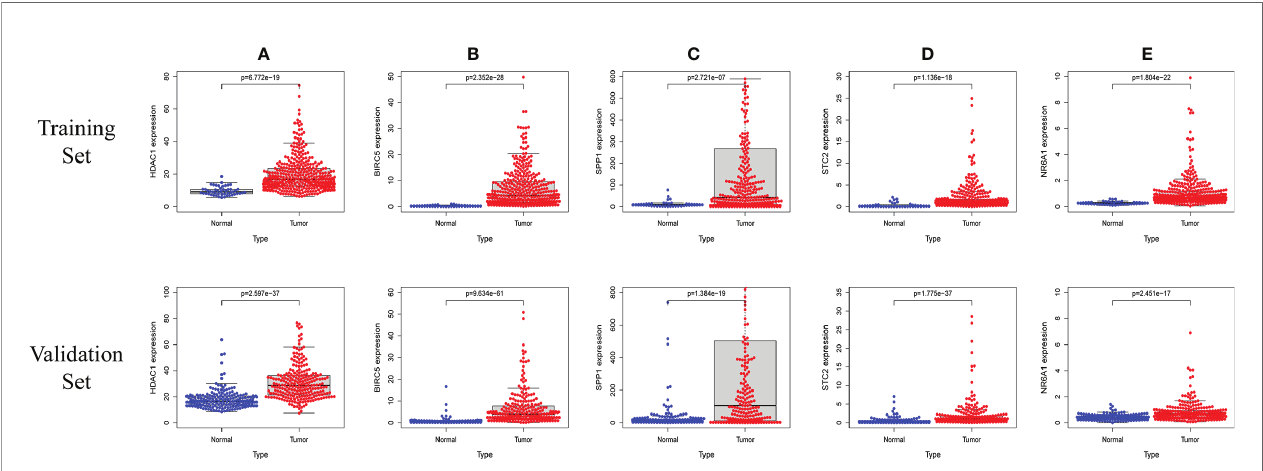
FIGURE 9 | The fi ve prognostic genes are upregulated in human HCC specimens: HDAC1 (A) , BIRC5 (B) , SPP1 (C) , STC2 (D) , NR6A1 (E) . Training Set: TCGA data showing the expression pro fi les of the fi ve prognostic genes in normal liver (n = 50) vs tumor tissue (n = 371). Validation Set: ICGC data showing the expression pro fi les of the fi ve prognostic genes in normal liver (n = 202) vs tumor tissue (n =